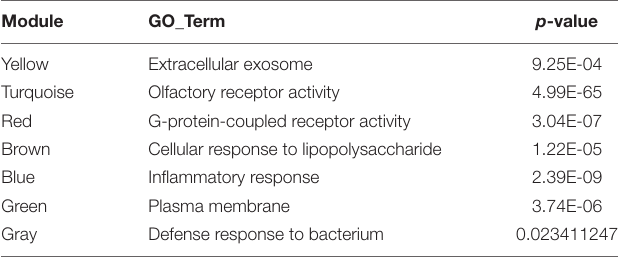
TABLE 2 | Gene ontology (GO) analysis results of modules constructed by WGCNA.